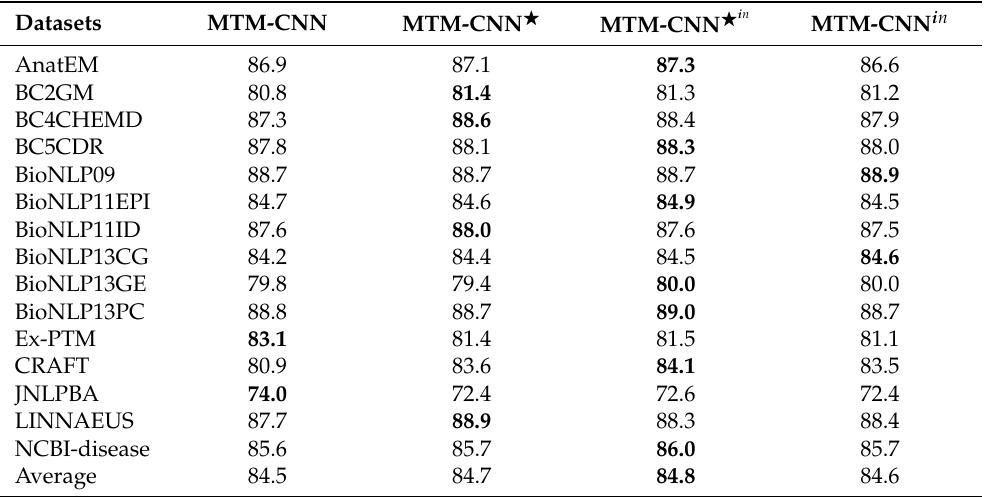
Table 4. Results comparison of proposed multitask learning approach with different auxiliary tasks and at different levels of the main